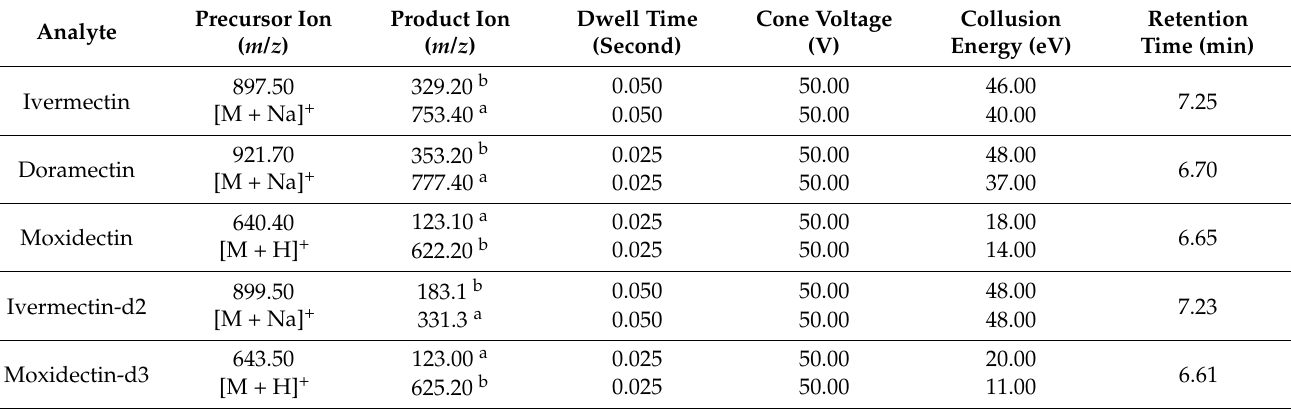
Table 1. Analyte specific MS/MS parameters obtained in the positive electrospray ionization mode.